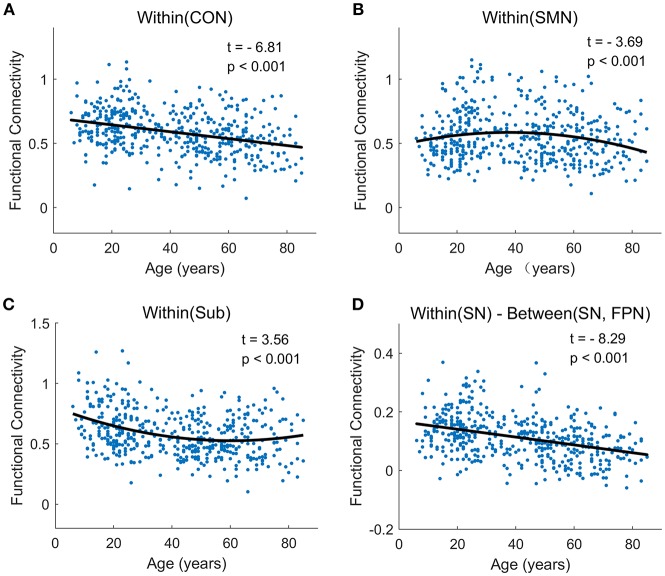
The typically developmental trajectories of functional connectivity at the network-average level. (A) Linear decrease with age in Within (CON) connectivity. (B) Negative quadratic change with age in Within (SMN) connectivity. (C) Positive quadratic change with age in Within (Sub) connectivity. (D) Linear decrease with age in Within (SN)-Between (SN, FPN) connectivity. The curve fits are shown by the dark lines.